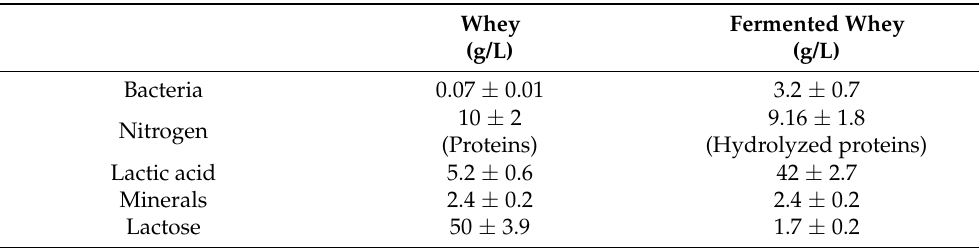
Table 1. Composition of both initial whey and fermented whey. Data are the means of three samples [11].